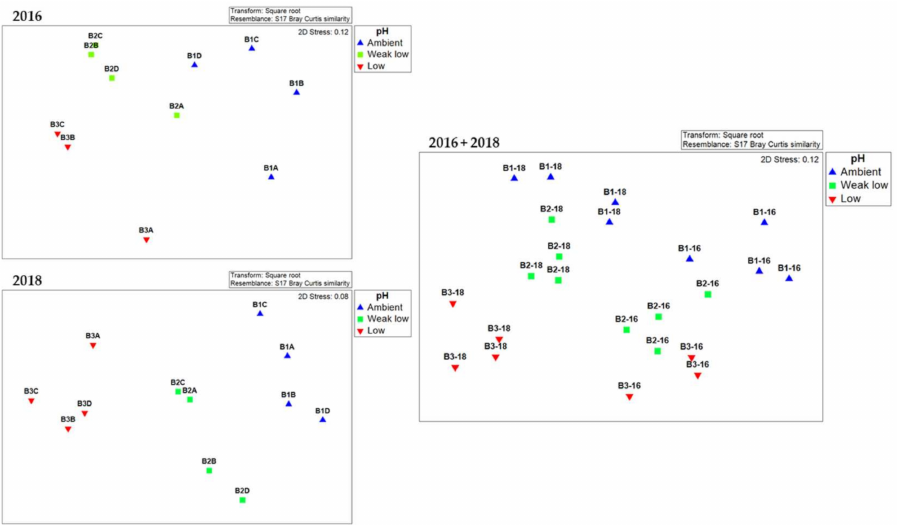
Figure 4. Non-parametric Multidimensional Scaling (nMDS) based on benthic invertebrate taxonomi- cal analysis collected in 2016 and 2018, and their pooled data (2016 + 2018) along the OA gradient off the Bottaro crater vents: B1 = ambient pH samples; B2 = weak low-pH samples; B3 = low-pH